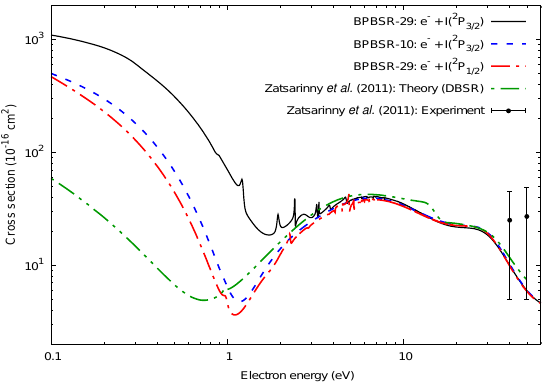
Figure 1. Elastic scattering cross section as a function of the electron energy. Cross sections for the ground state obtained in the BPBSR-10 and BPBSR-29 models are shown, as well the BPBSR-29 prediction for the first excited state and the result from the DBSR calculation reported by Zatsarinny et al. [25]. The experimental data at 40 eV and 50 eV are taken from ref.